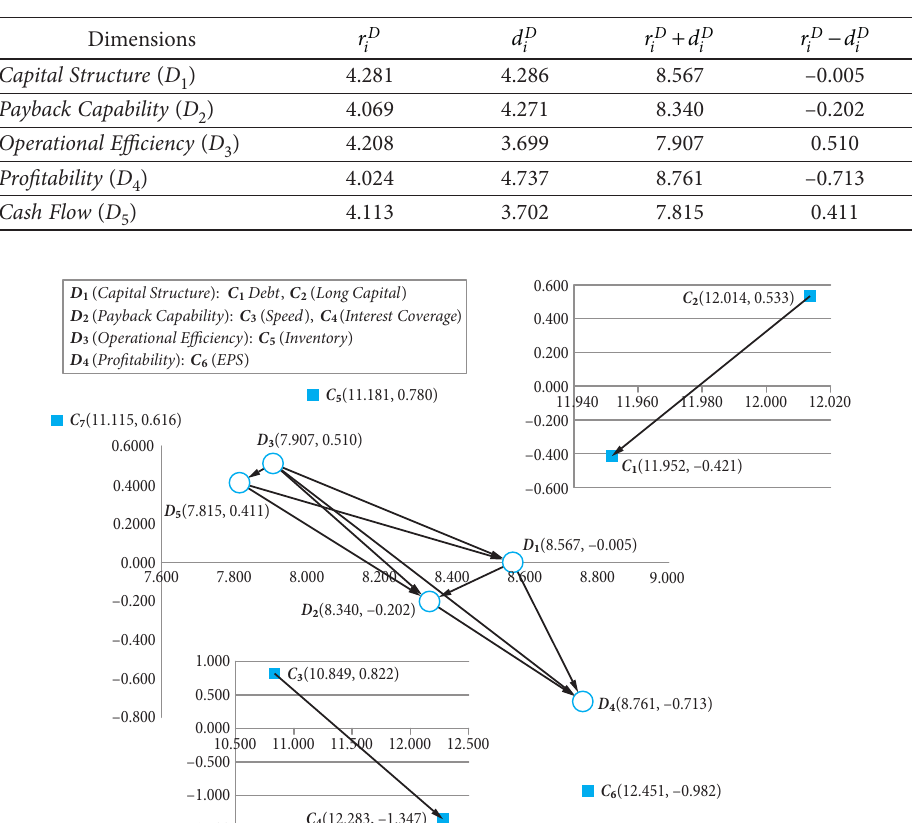
Table 7. Relative influences of dimensions